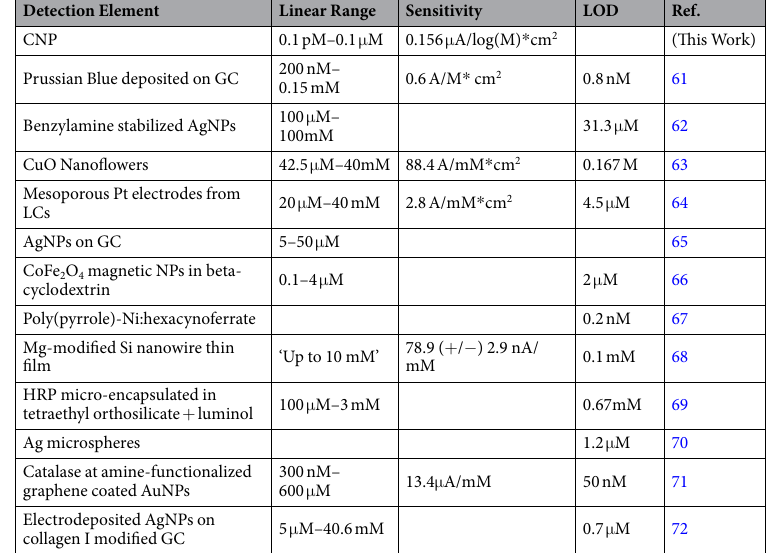
Table 2. H 2 O 2 Sensors and their Properties.